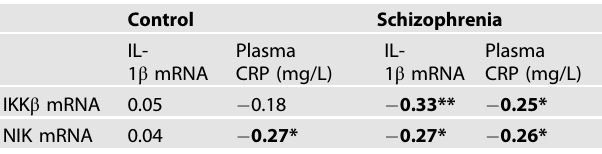
Table 3. Correlations between levels of IKK β and NIK mRNAs with in fl ammatory biomarkers in controls and people with